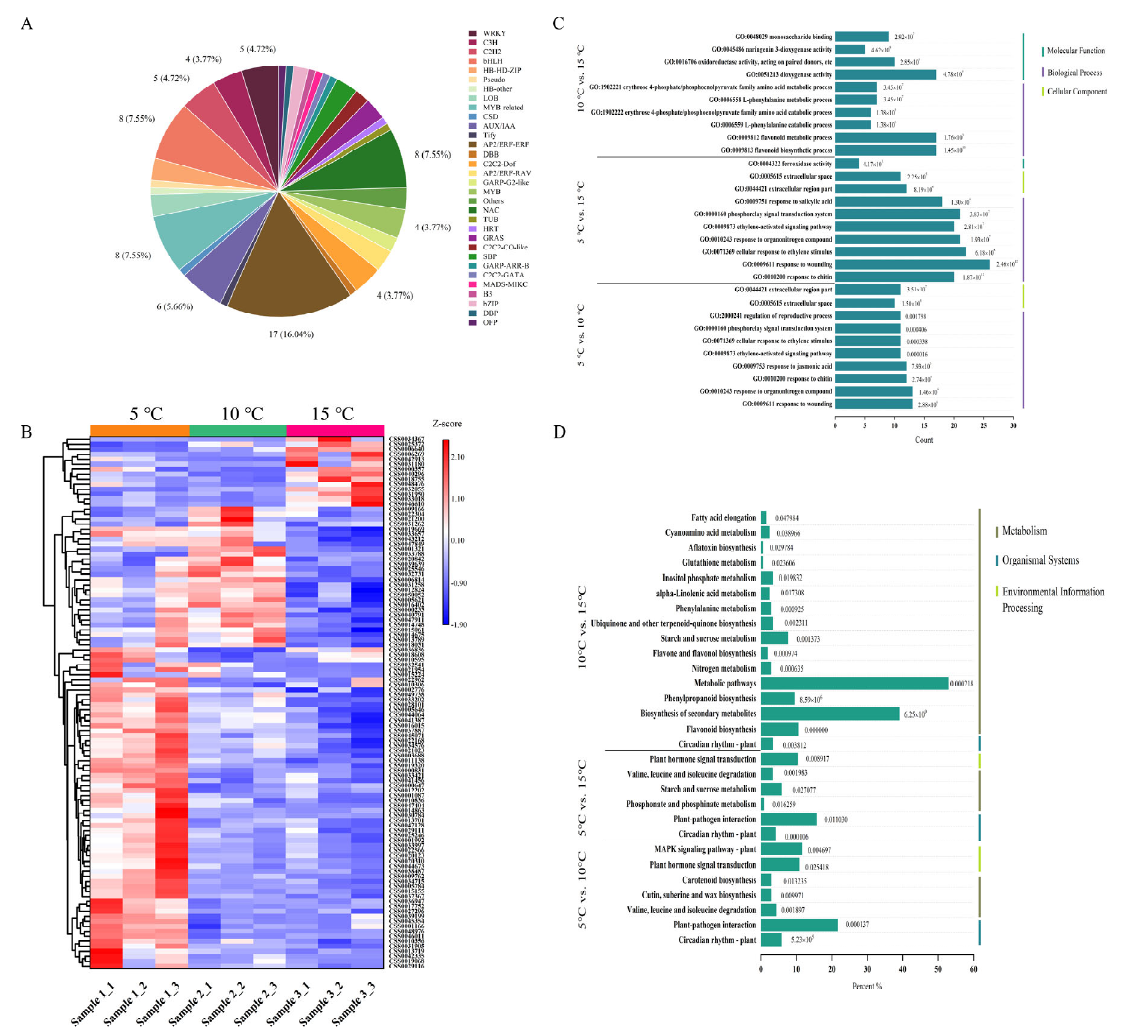
Figure 5. Annotation of the differentially expressed genes. ( A ) The classification of the differentially expressed transcription factors; ( B ) The clustering heat map of the differentially expressed transcrip ‐ tion factors; ( C ) GO enrichment analysis for the DEGs between the comparison groups; ( D ) KEGG enrichment analysis for the DEGs between comparison groups. Numeral 1 represents the 5 °C DIF treatment; numeral 2 represents the 10 °C DIF treatment; and numeral 3 represents the 15 °C DIF treatment.